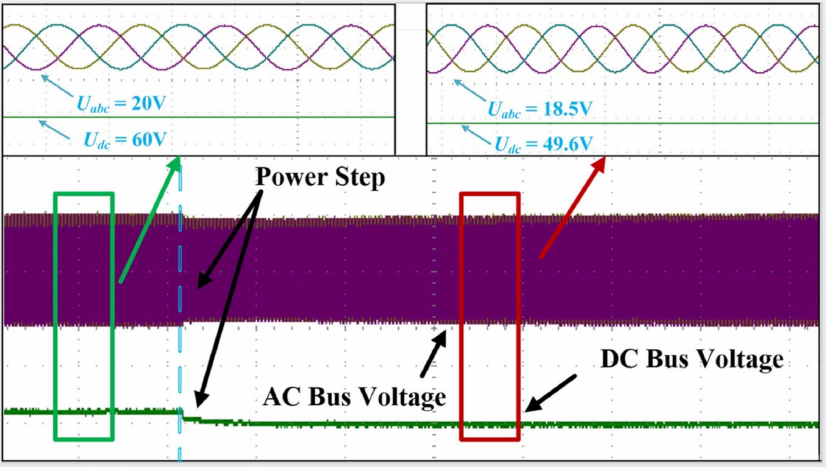
Figure 17. AC and DC bus voltage waveforms of microgrids with the battery in discharging mode (CPL power increased from 40 W and 100